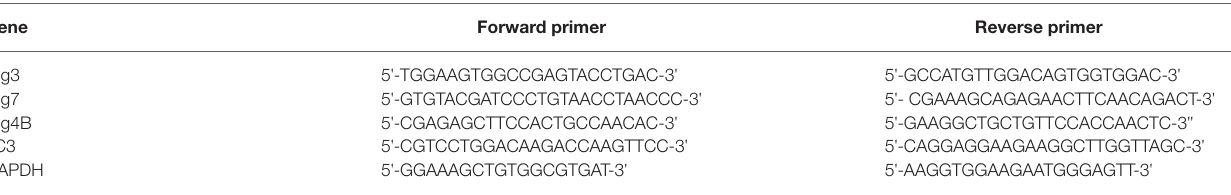
TABLE 1 | Sequences of the